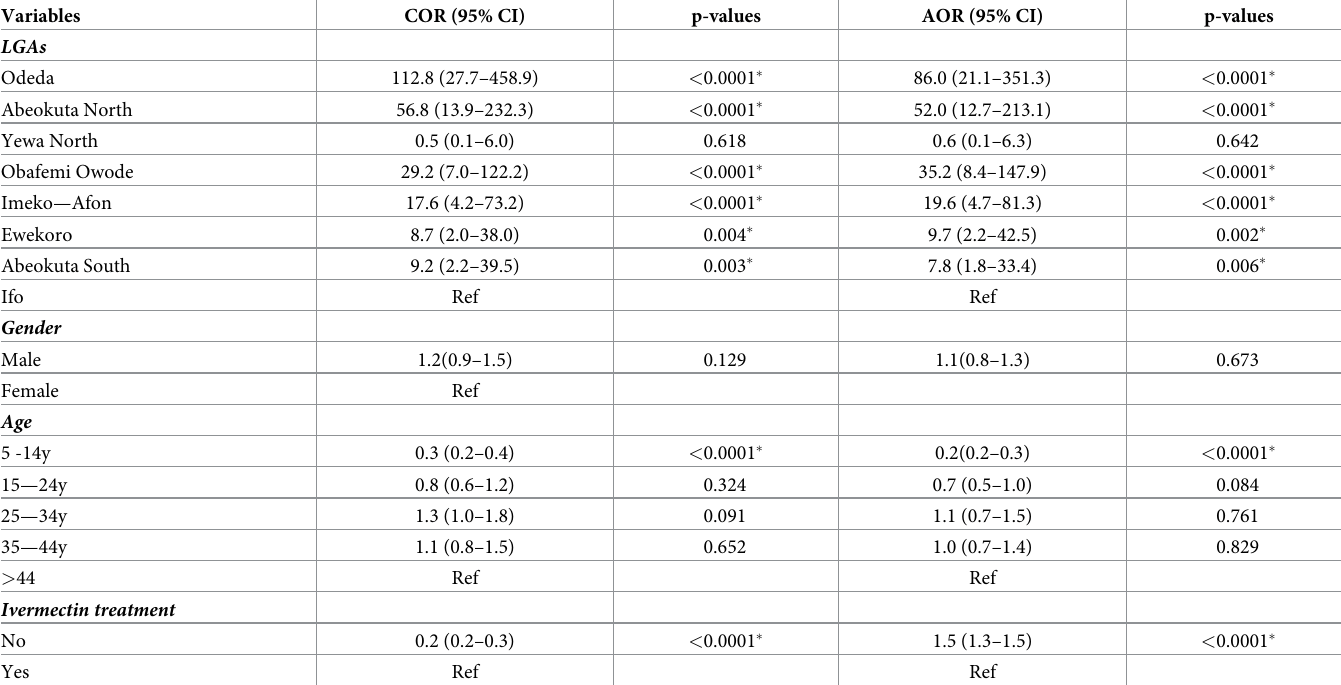
Table 3. Logistic regression model for predictors of O . volvulus infection among the study